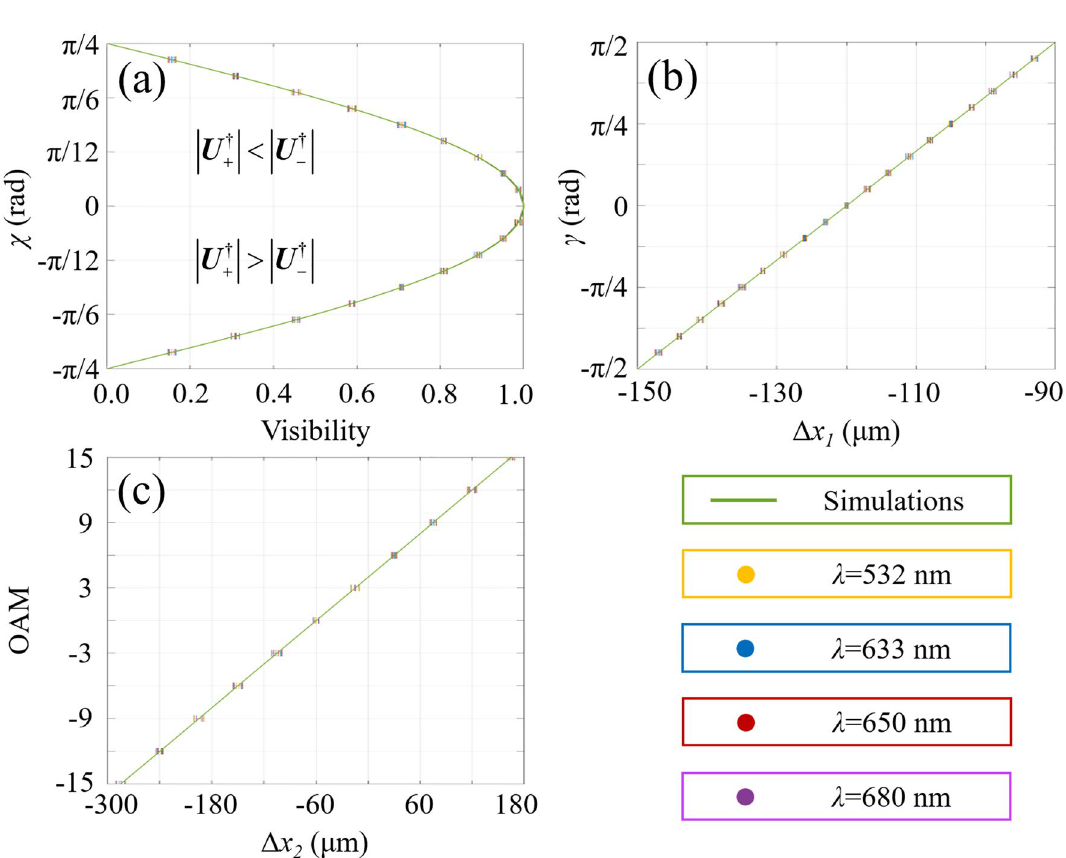
Figure 6. Theoretical simulations (curves) and experimental results (error bars) of single-shot decoding of scalar vortex states under various wavelength